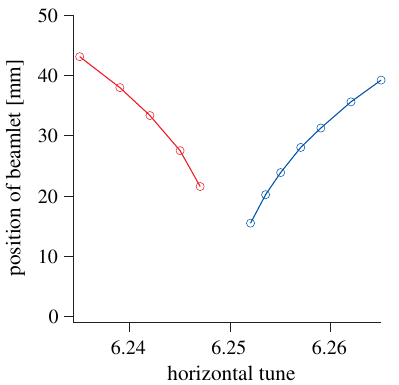
FIG. 7. Evolution of the position of one of the fixed points as a function of the horizontal tune for the two cases with negative (blue) and positive (red) value of h 2 . In both cases no intensity- ; 0 dependent effects are taken into account.